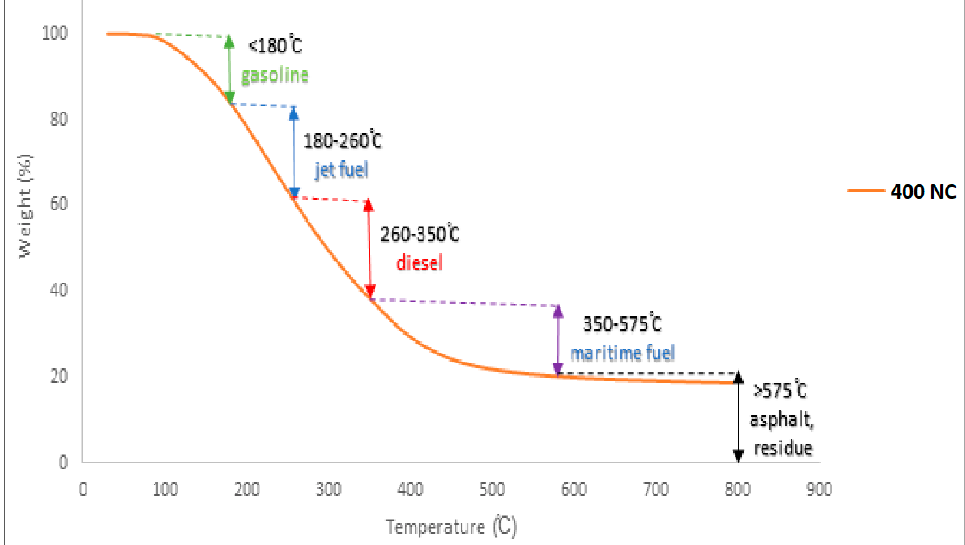
Figure 3. Thermogravimetric curves of the biocrudes obtained at 400 °C.